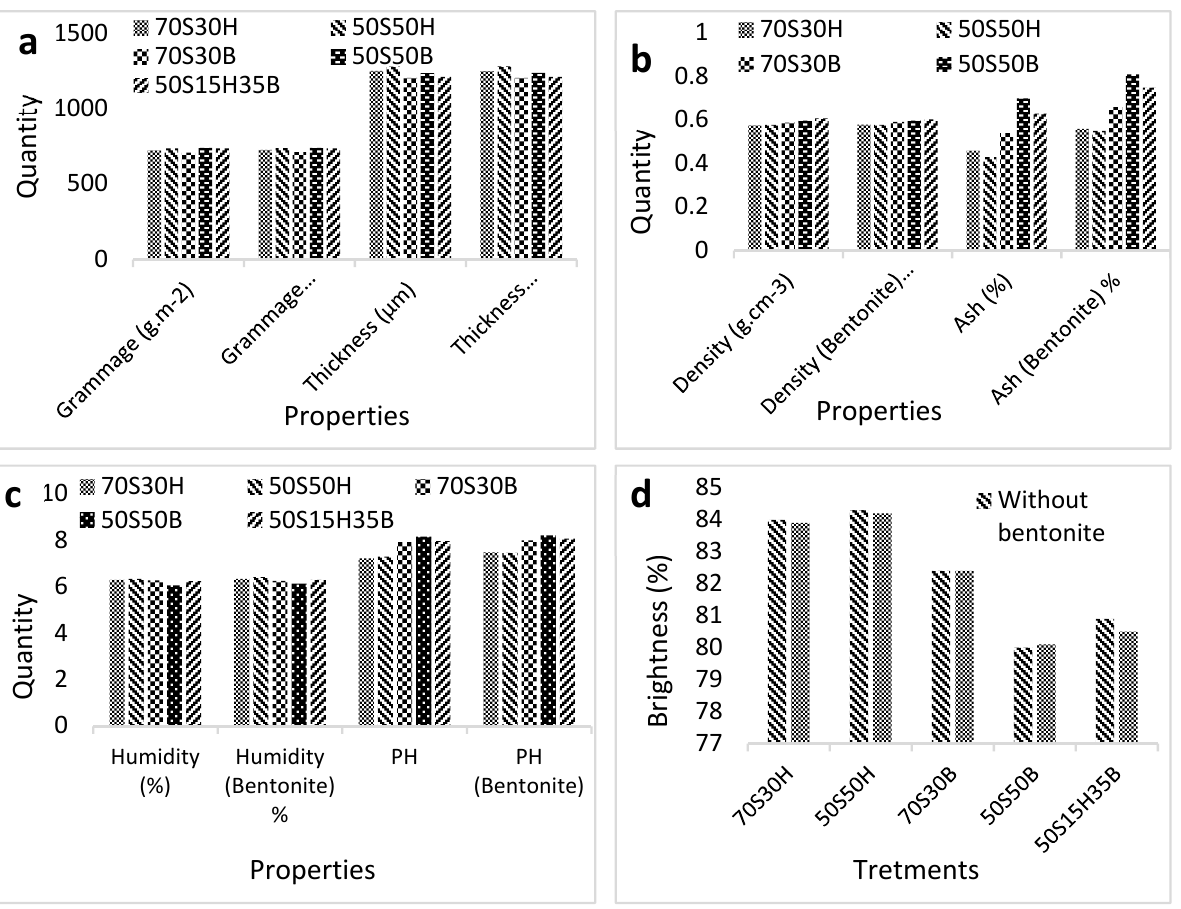
Figure 4. Grammage and thickness ( a ), density and ash content ( b ), humidity and pH ( c ) and brightness ( d ) of manufactured fluff pulp.